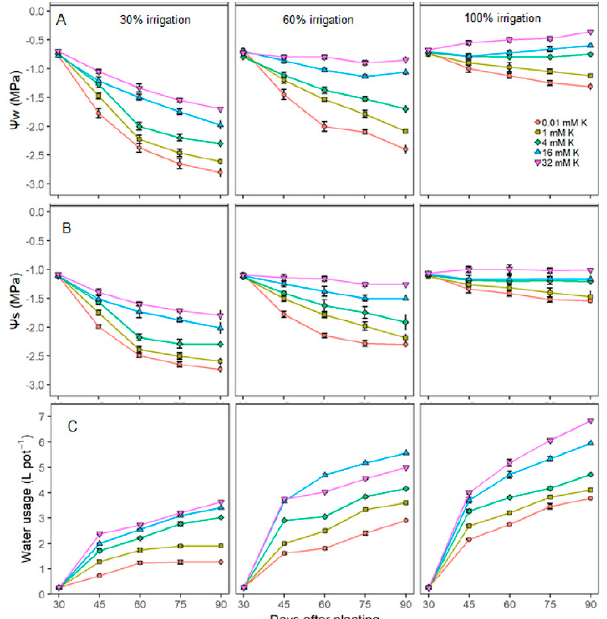
days after planting; I = irrigation; K = potassium; S.E.M. = standard error of the mean; df = degrees of freedom.